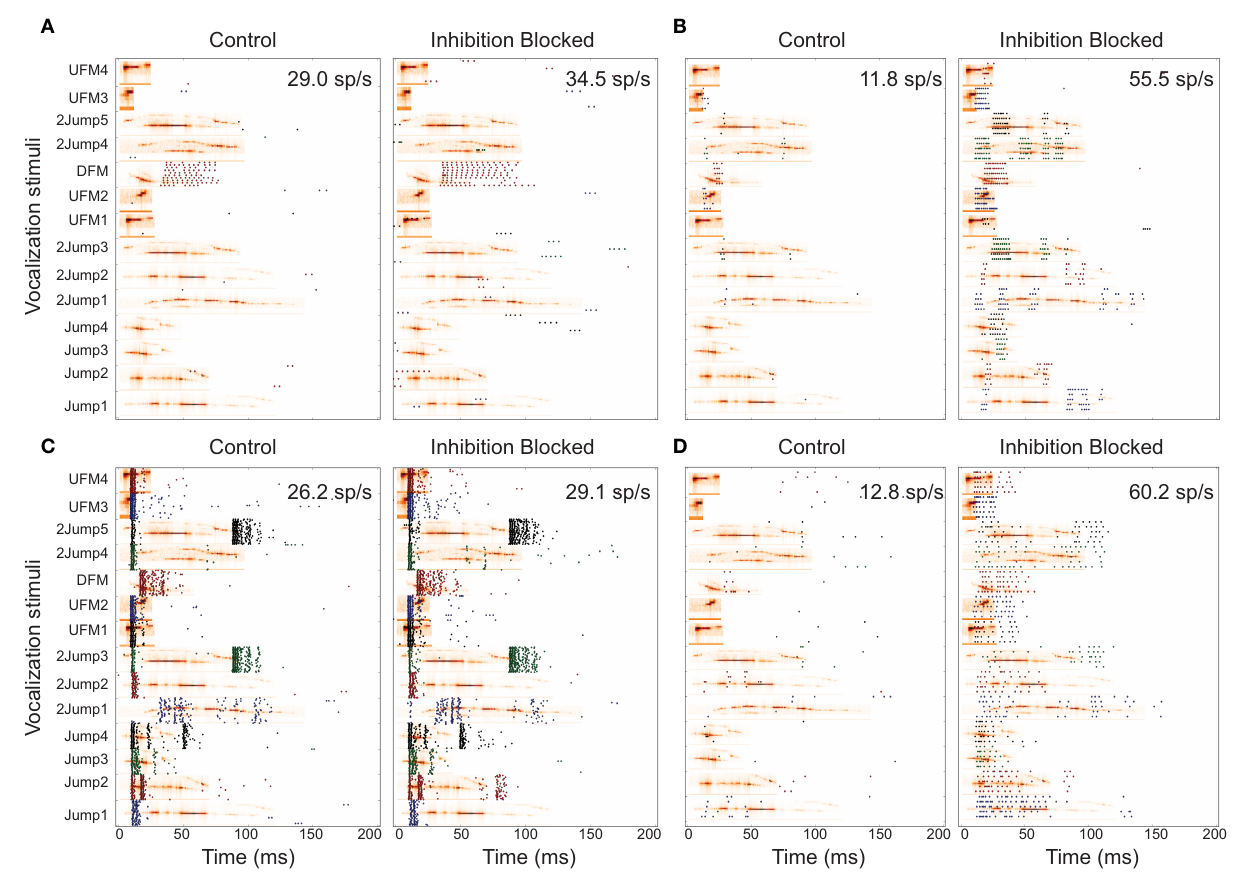
FIGURE 3 | Neural responses from different classes. Panel pairs contain responses in control condition and inhibition blocked condition, respectively. Responses are shown for vocalization stimuli, at the preferred attenuation. Responses are represented as a spike raster, with each detected action potential indicated by a dot. The horizontal axis represents time of occurrence with 0 being the start of stimulus presentation. Responses to the 14 different vocalizations are